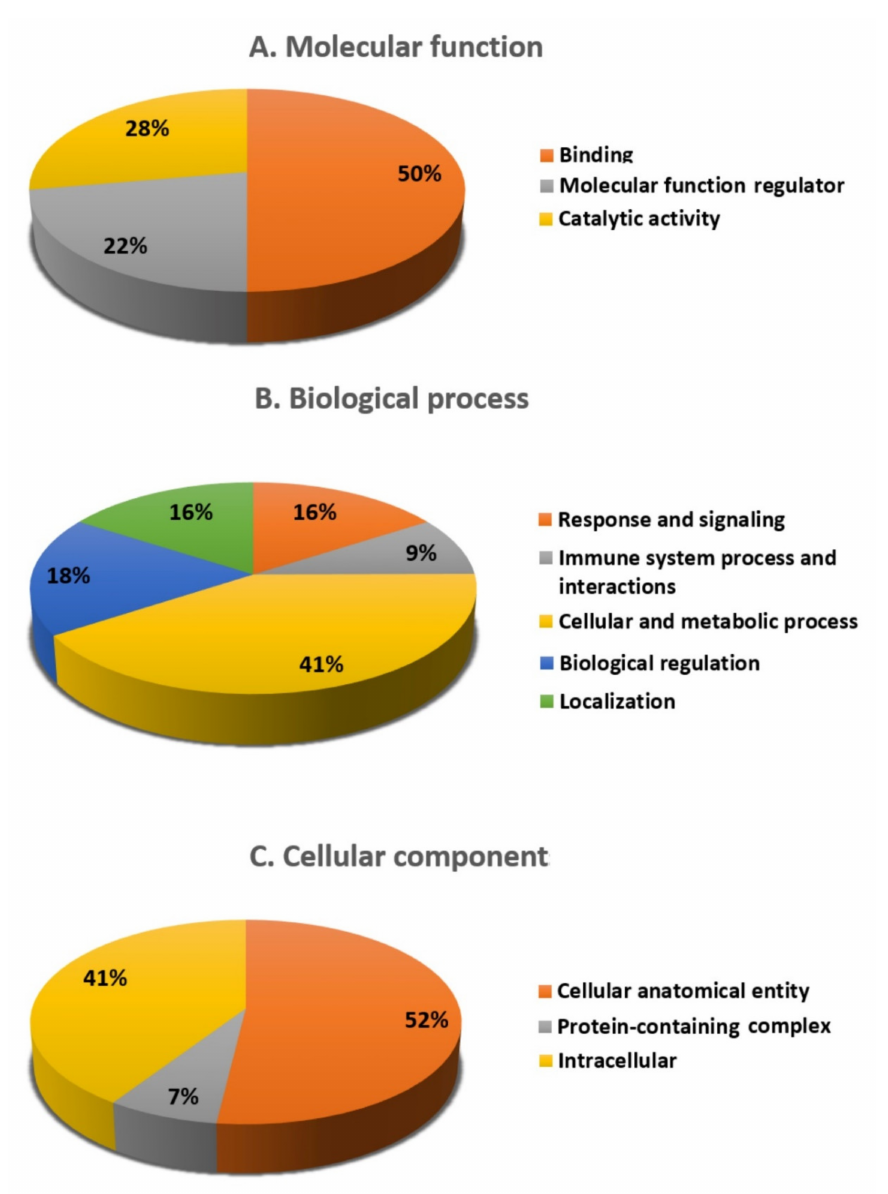
Figure 5. Comparative representation (%) of reported proteins divided into groups based on their cellular components ( A ), molecular functions ( B ), and biological processes ( C